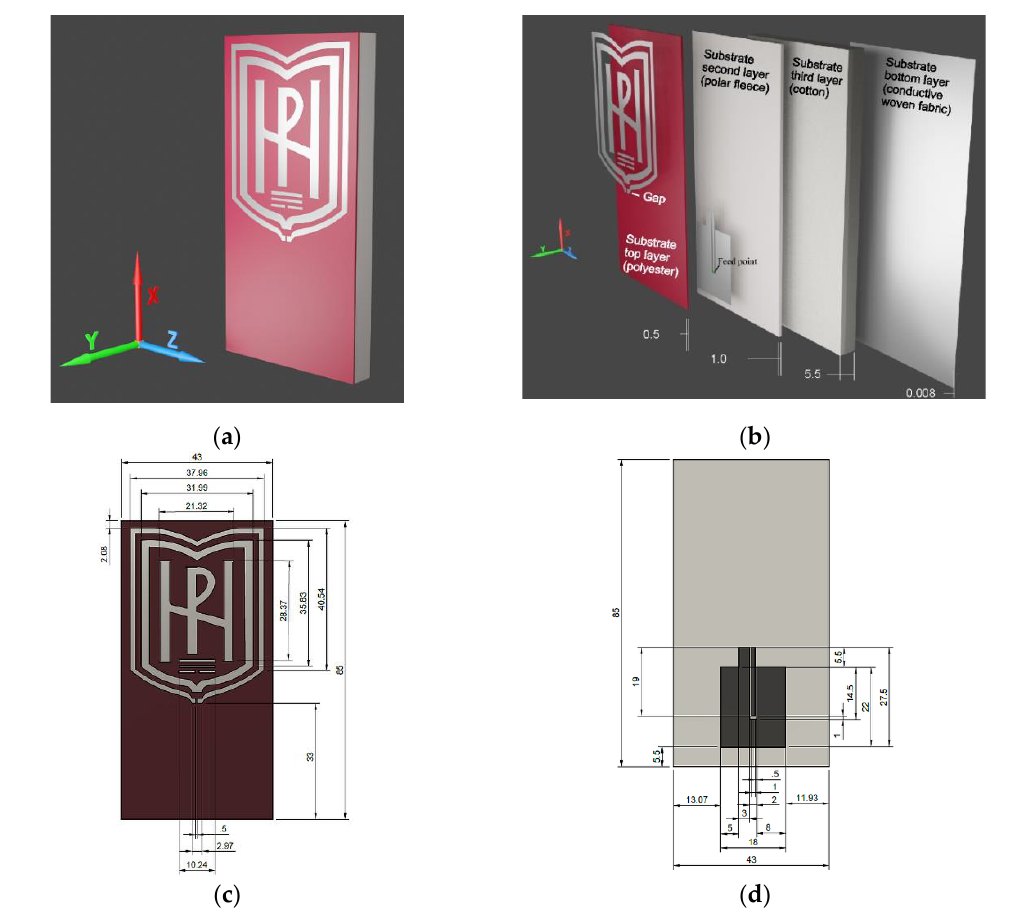
Figure 1. Configuration of the proposed antenna: ( a ) 3D view; ( b ) decomposition view; ( c ) top view with dimensions; ( d ) top view of substrate second layer with dimensions. Dimensions indicated in the figure are in